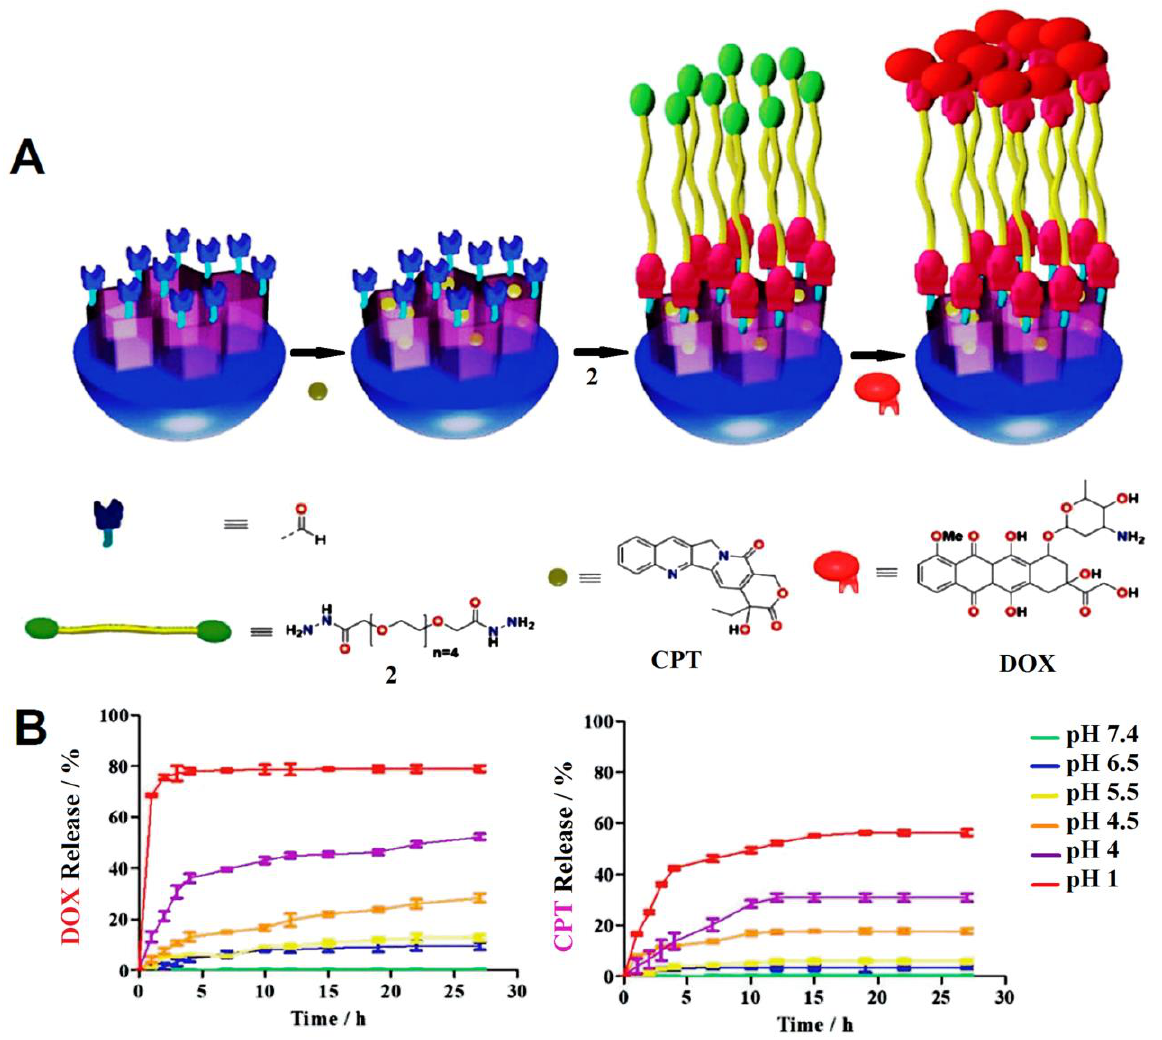
Figure 3. ( A ) Schematic process of capping the CPT-loaded nanoparticles with DOX. ( B ) DOX and CPT release profiles in various pH values in CPT@MSN-hyd-PEG-hyd-DOX. Reproduced from